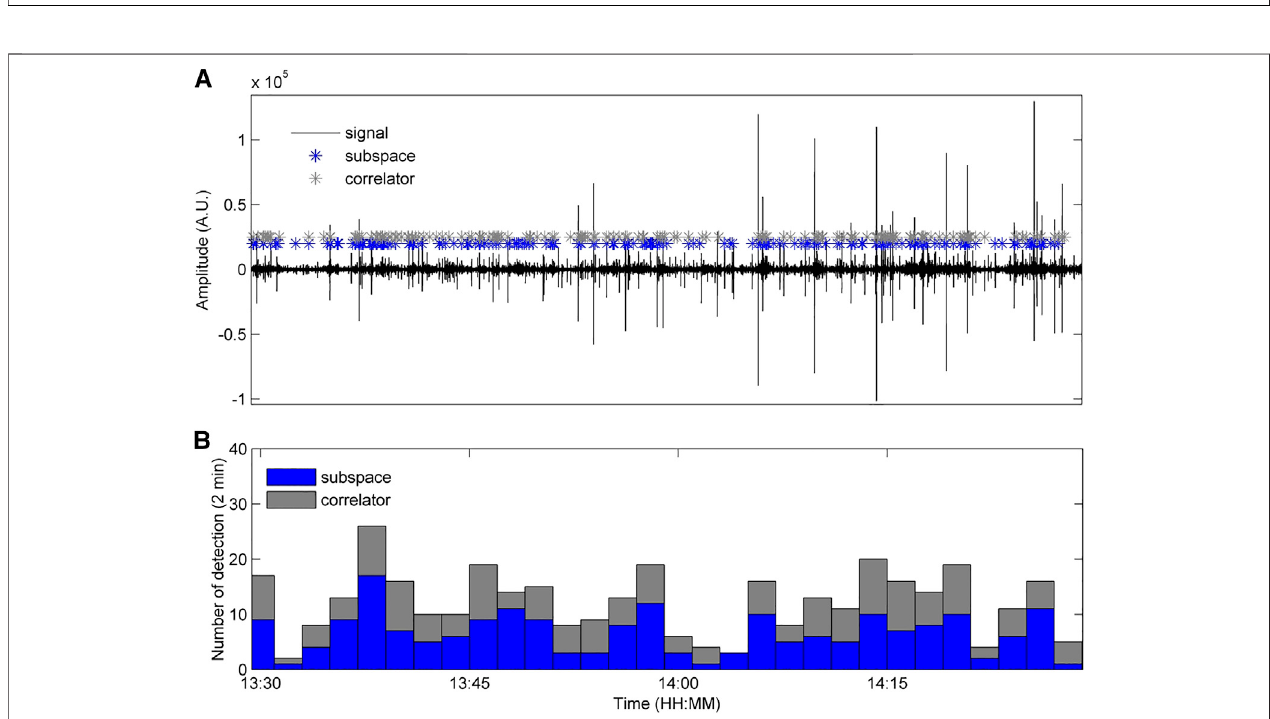
FIGURE 10 | Signal recorded at EMFO station and fi ltered in the band 0.5 – 10 Hz with the overlapped positions of detections obtained in 1-s long window by subspace(blueasterisks)andcorrelation(greenasterisks)detectionalgorithmsfor99.9percentileandusing fi veSVD (A) .Eventoccurrencerateresultingfromsubspace and correlation detection algorithm counted in 2-min-long window (B)